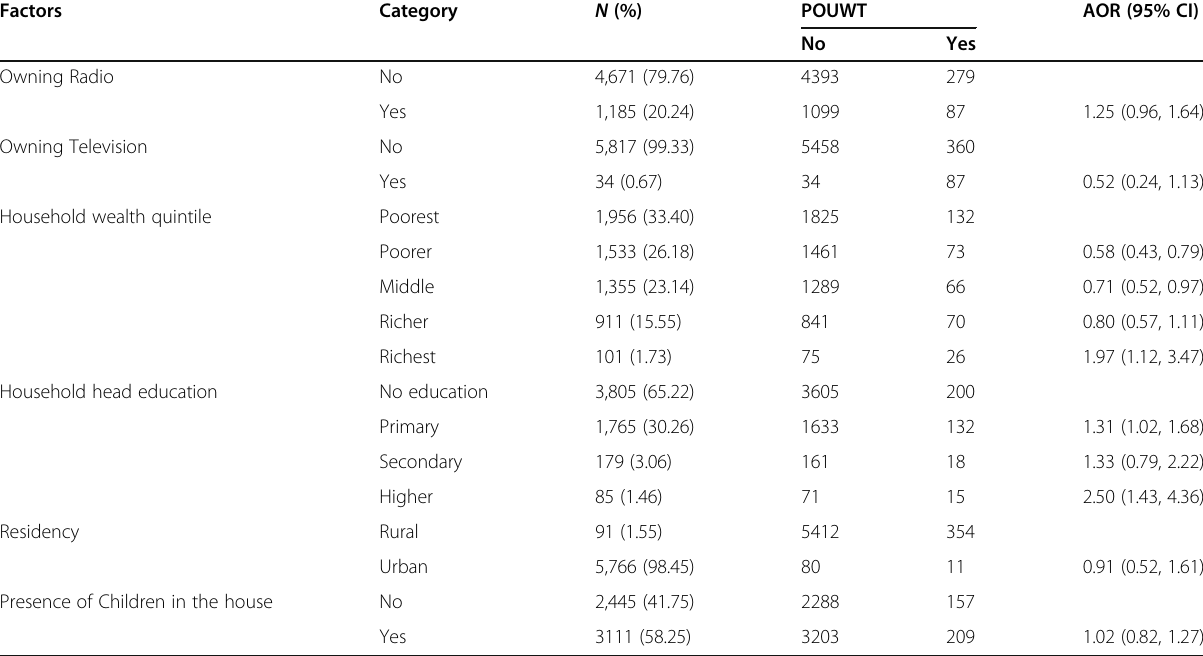
Table 1 Point-of-use water treatment practices among households with unimproved water sources and associated factors, EDHS, 2016